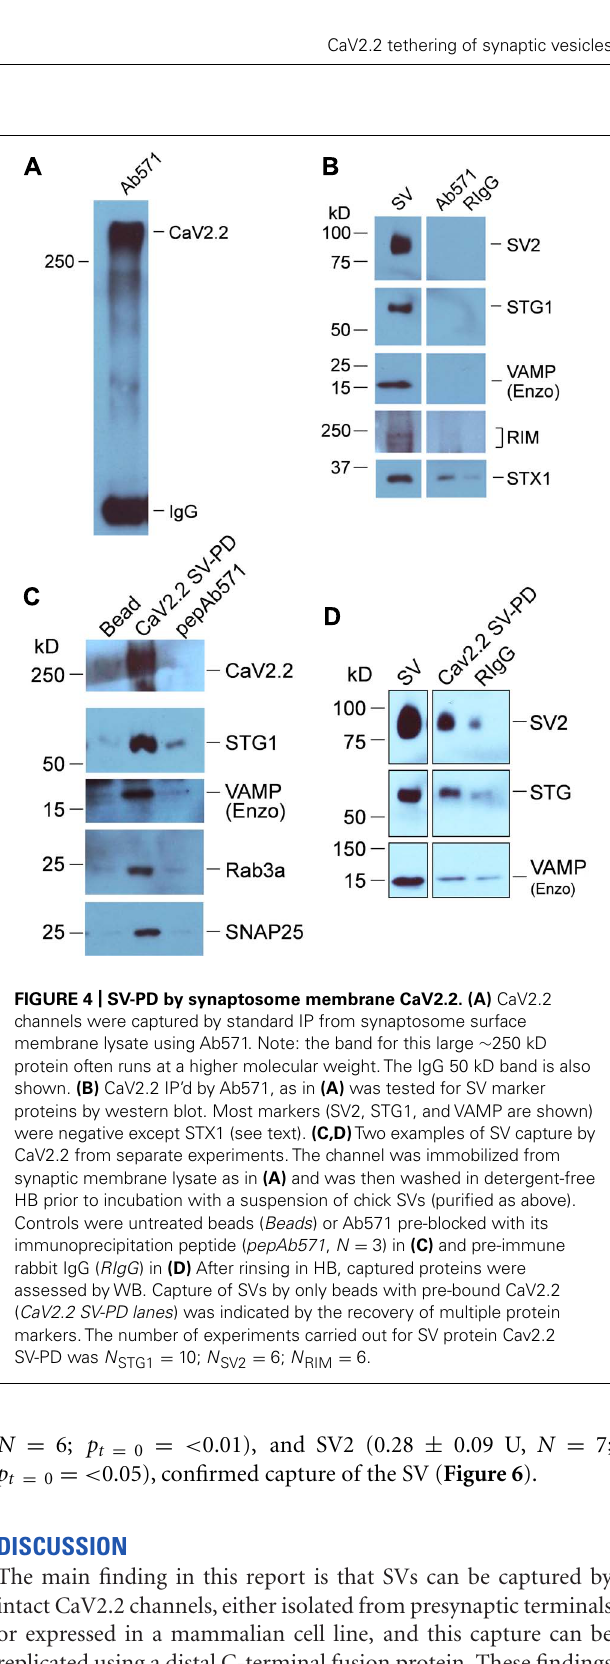
N = 6; p t = 0 = < 0.01), and SV2 (0.28 ± 0.09 U, N =